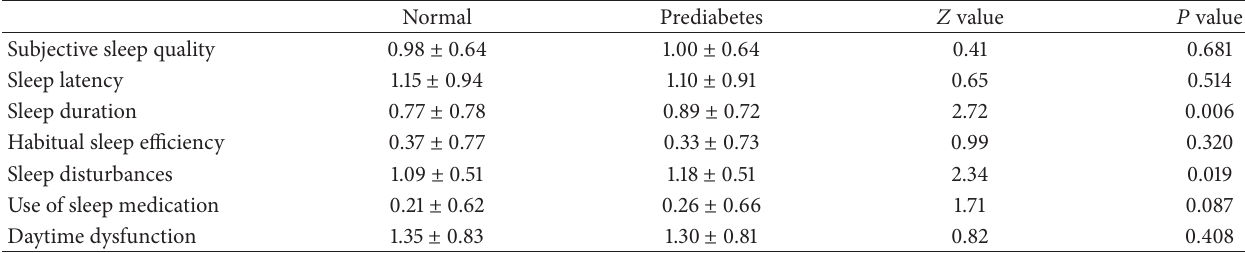
Table 1: PSQI scores of the study